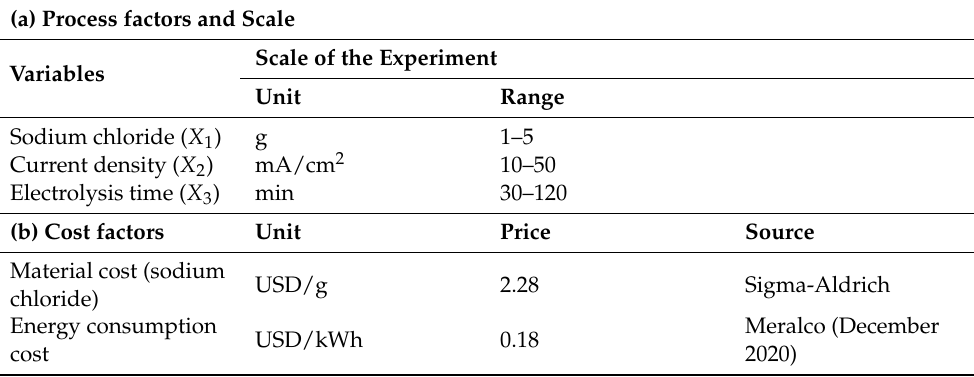
Table 2. Ammonia removal by the electro-oxidation process: Box-Behnken design matrix. Sodium Run